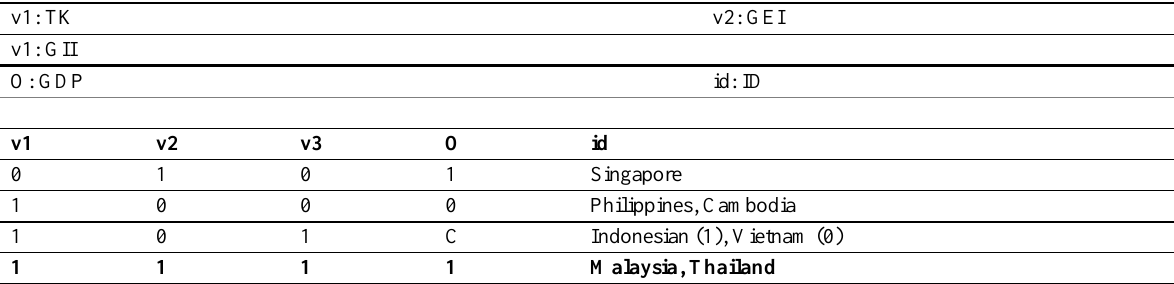
Table 5: Result of Truth Table